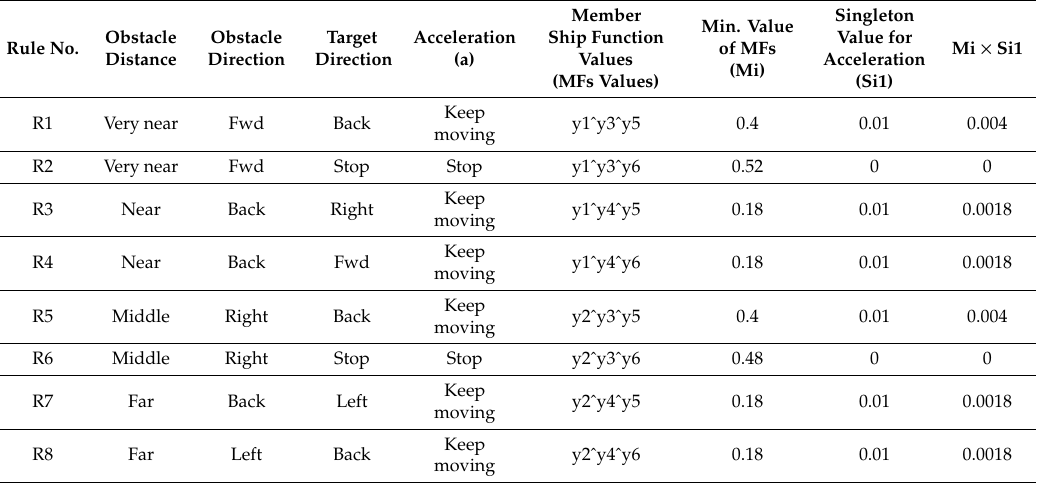
Table 1. Calculations for acceleration.